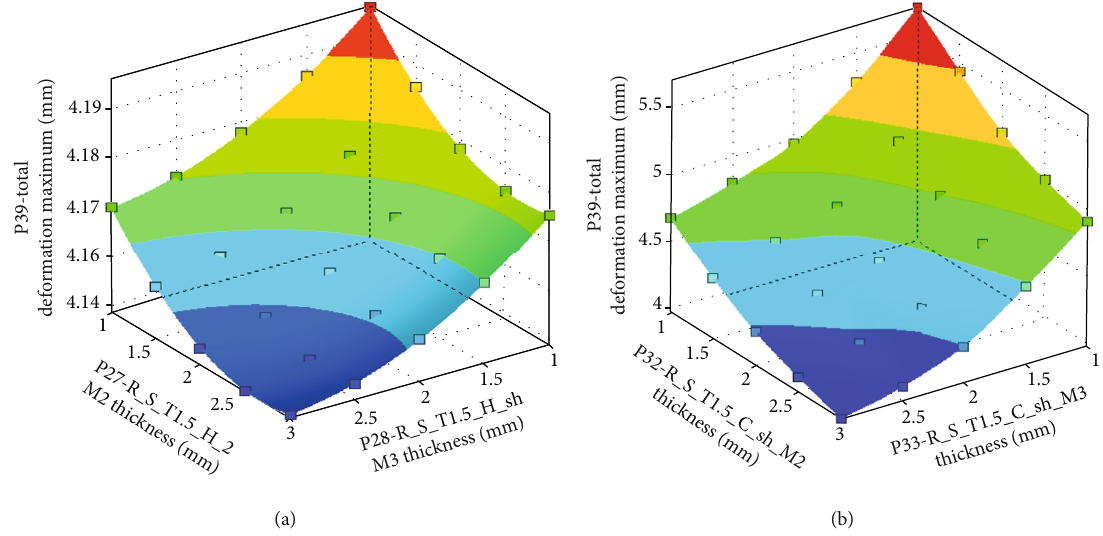
Figure 13: Representation of the 3D response surface for four input variables.